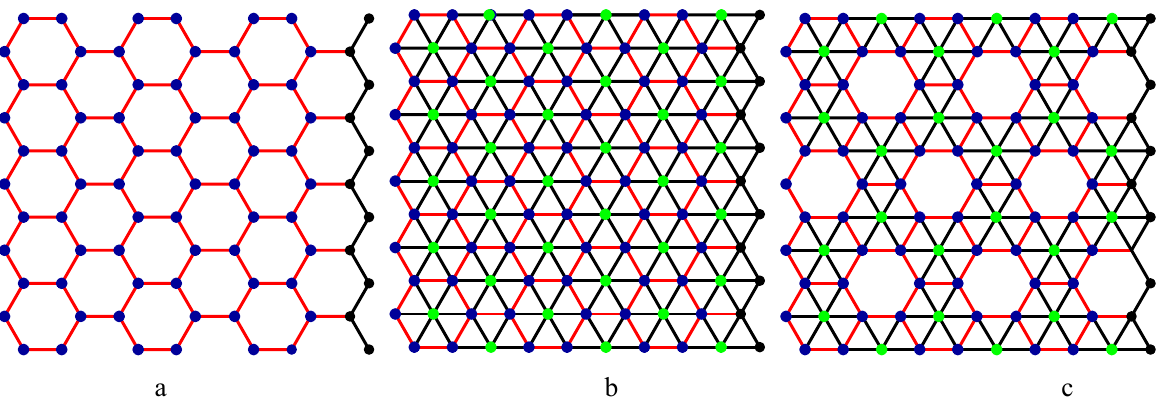
a b c Green bullets are the new vertices added to hexagonal sheet to form boron triangular sheet and boron α -sheet respectively.